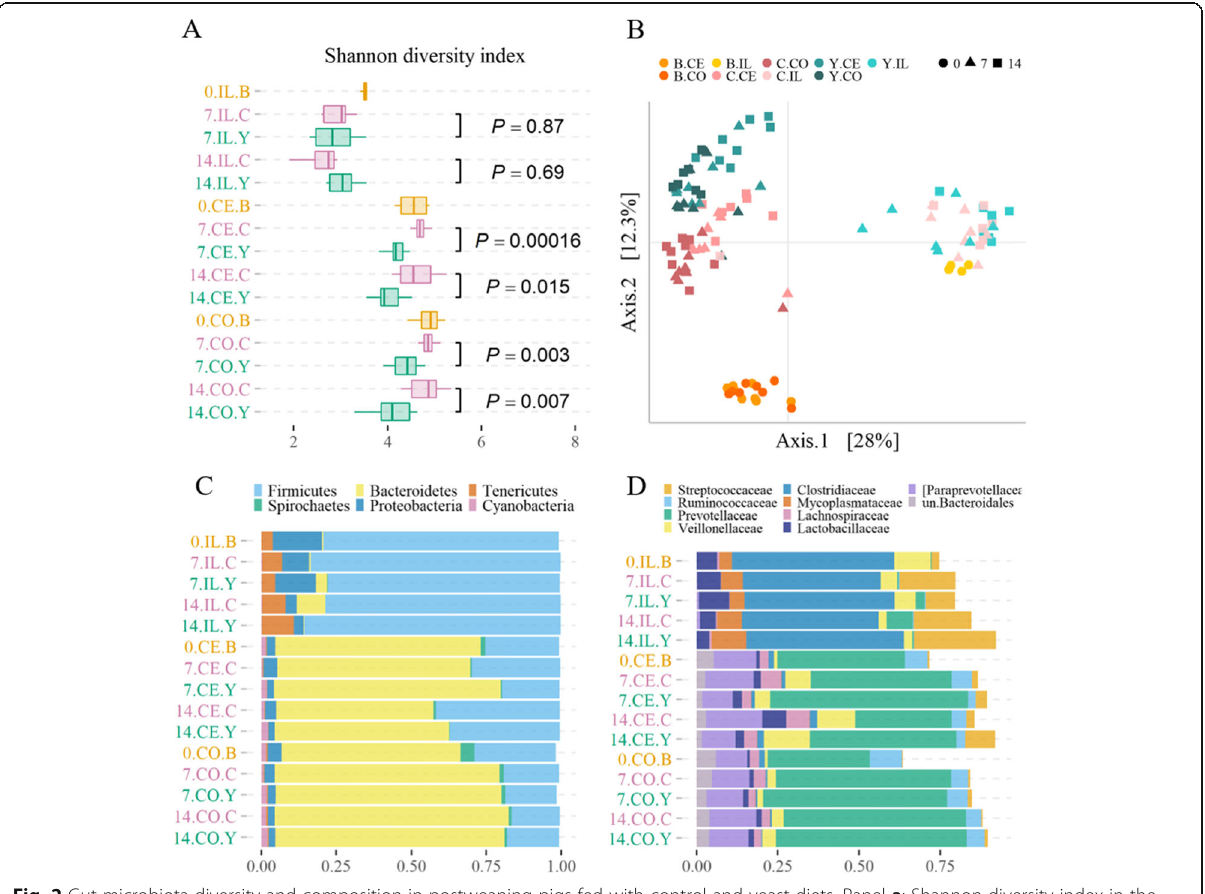
Fig. 2 Gut microbiota diversity and composition in postweaning pigs fed with control and yeast diets. Panel a : Shannon diversity index in the pig gut microbiota denoted by day, gut site, and diet ( 0 day 0 PW, 7 day 7 PW, 14 day 14 PW; IL ileum, CE caecum, CO colon; B baseline diet, C control diet, Y yeast diet) and coloured by diet (baseline orange ; control pink ; yeast dark cyan ). The p-values derive from MWW test comparing the averages of the Shannon diversity index between the diets at each sampling day (n = 8). The box size corresponds to IQRs with the median value represented as the lines inside the box. The whiskers represent upper and lower quartiles of the diversity estimates. Panel b : Principal coordinate analysis plot of pig gut microbiota coloured by diet and gut segment ( B.CE baseline caecum, orange ; B.CO baseline colon, dark orange ; B.IL baseline ileum, yellow ; C.CE controls caecum, dark pink ; C.CO controls colon, indian red ; C.IL controls ileum, light pink ; Y.CE yeast caecum, dark cyan ; Y.CO yeast colon, teal ; Y.IL yeast ileum, cyan ) and shaped by the day PW ( ● day 0; ▲ day 7; ■ day 14). Panel c : Stacked bar plot showing group average relative abundance of six top abundant bacterial populations at the phylum level in the pig gut denoted by day, gut site, and diet ( 0 day 0 PW, 7 day 7 PW, 14 day 14 PW; IL ileum, CE caecum, CO colon; B baseline diet, C control diet, Y yeast diet) and coloured by diet (baseline orange ; control pink ; yeast dark cyan ). The x-axis shows the relative proportions of the bacterial groups coloured with distinct colours. Panel d : Stacked bar plot showing group average relative abundance of ten top abundant bacterial populations at the family level in the pig gut denoted as in the panel